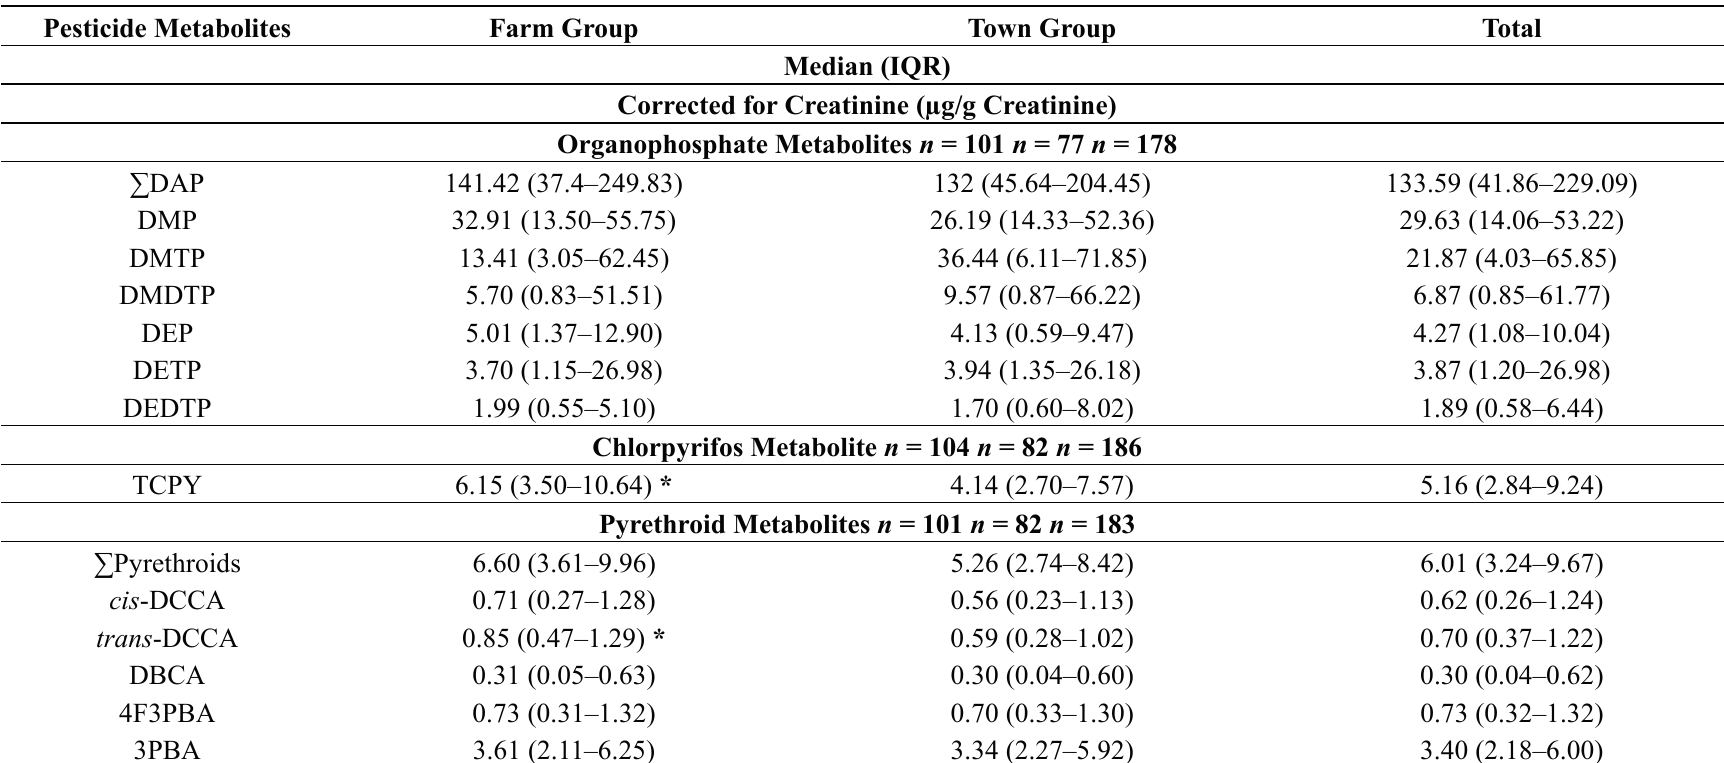
Table 3. Pesticide residues levels among rural female